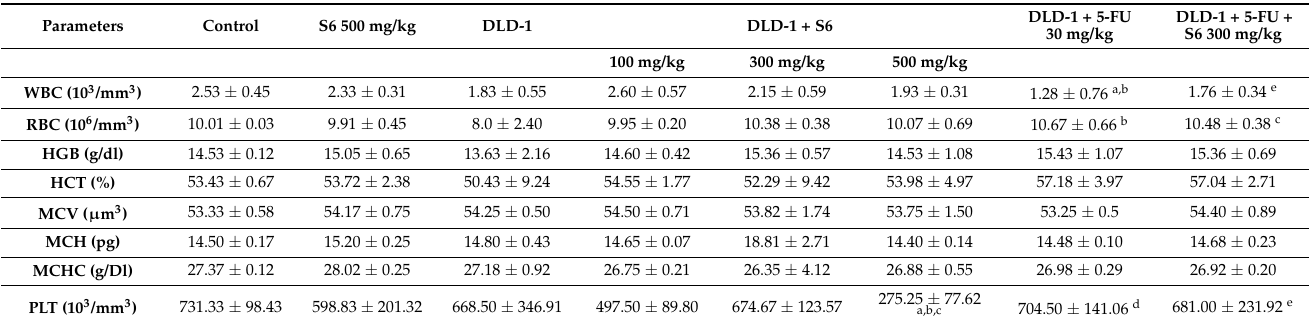
Table 2. Morphological blood parameters of control and experimental